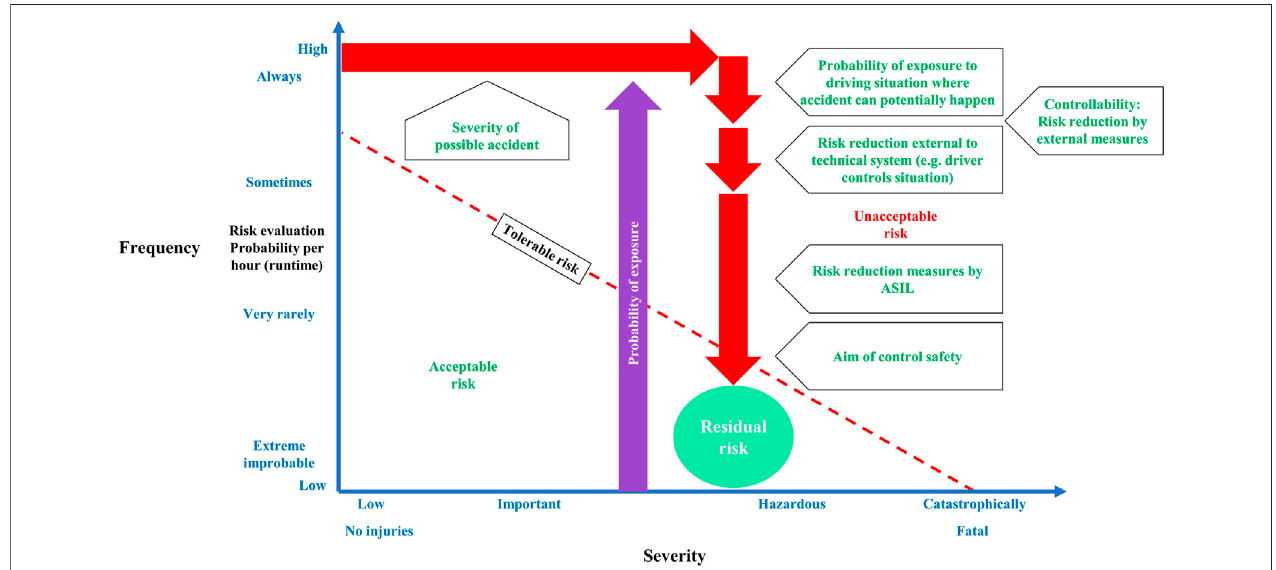
FIGURE 11 | Illustration of limits of the tolerable and residual